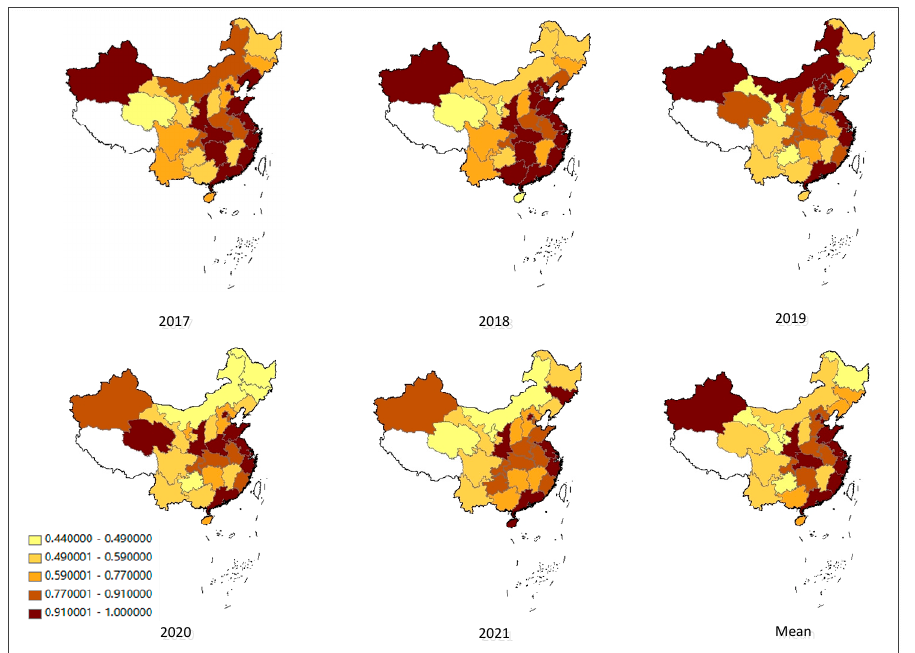
Figure 1. Overall green buildings’ implementation efficiency during 2017–2021.